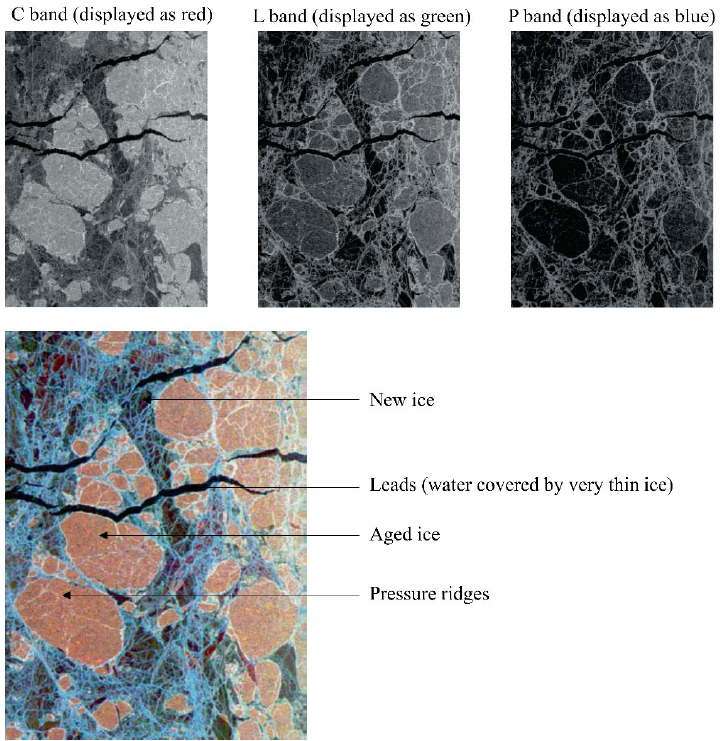
Figure 3. Different properties of SI in different channels of SAR images [94].